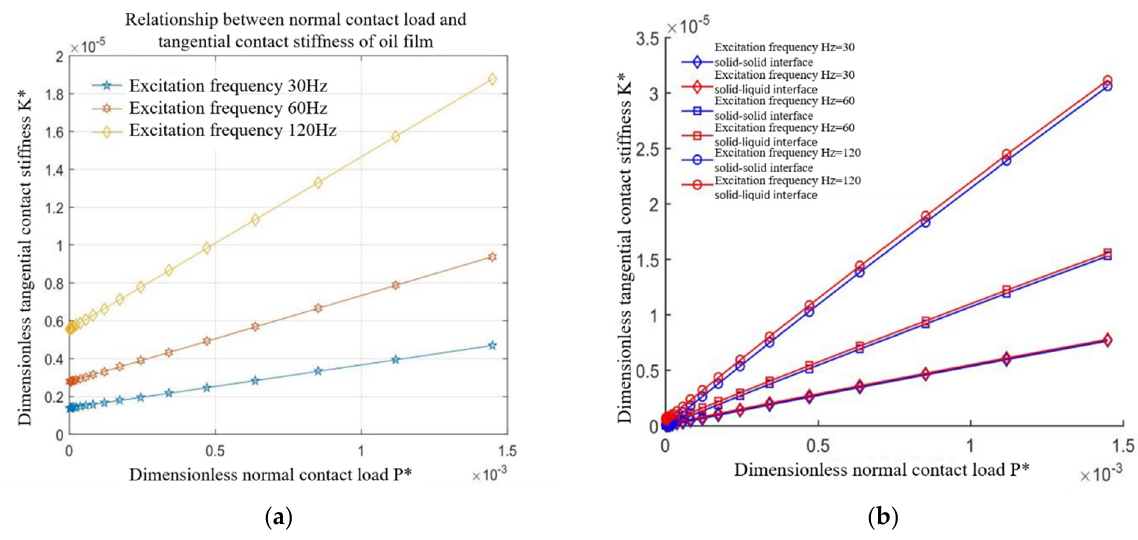
Figure 4. Relationship between the tangential contact stiffness of a solid − solid interface and a solid–liquid interface and a normal contact load. ( a ) Fluid contact characteristics, ( b ) solid − solid to solid − liquid interfaces.